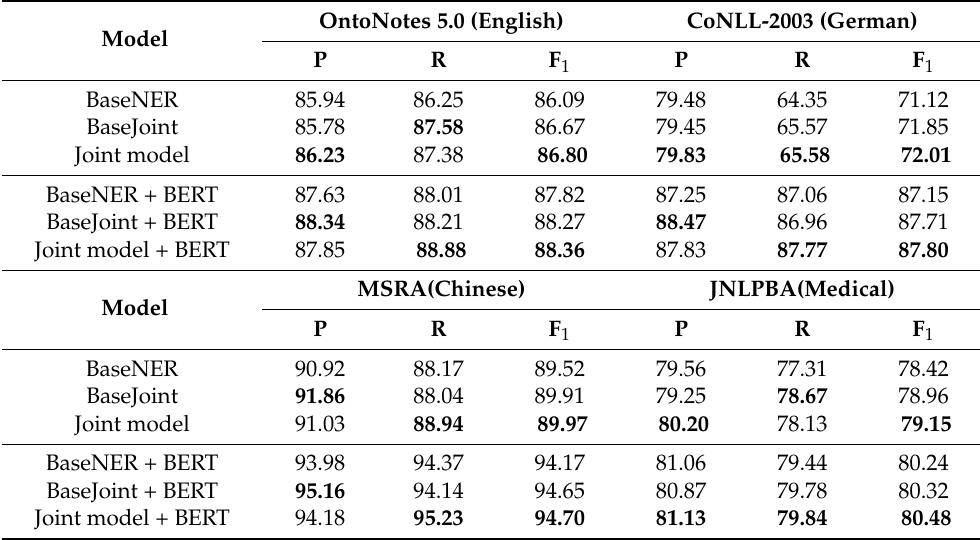
Table 3. The P, R and F 1 of development sets on four datasets.